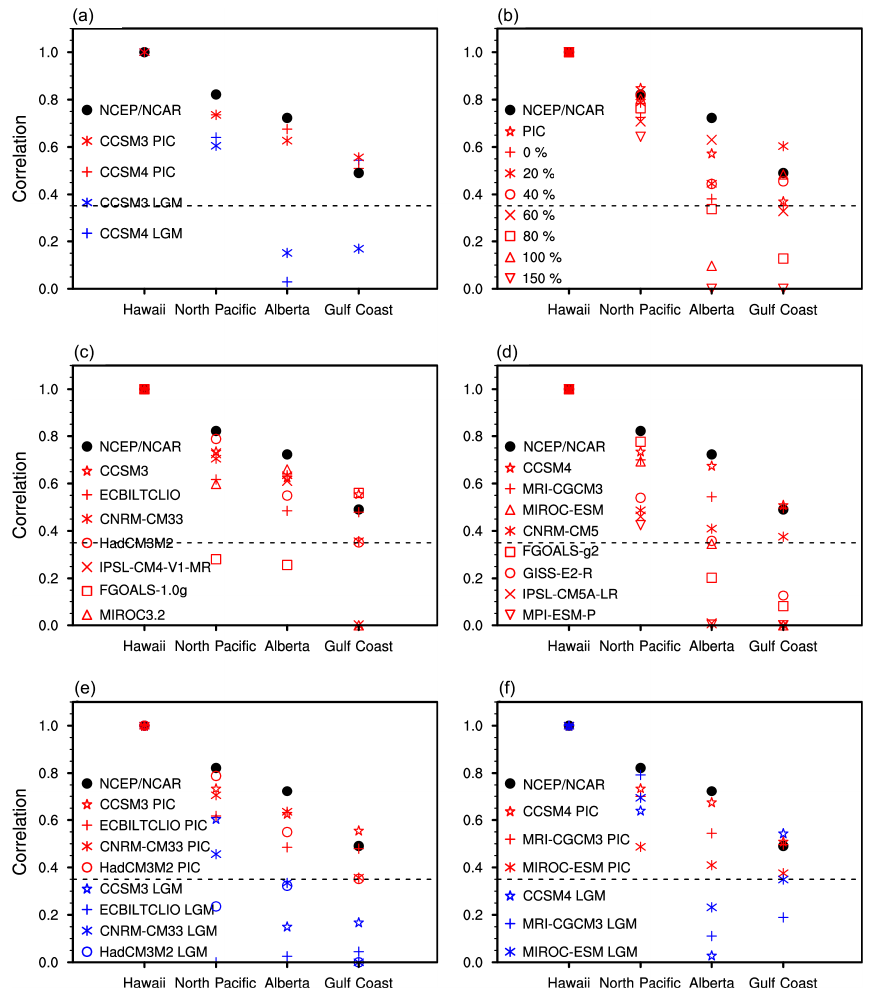
Figure 3. Correlation coefficients at the four PNA action centers in PIC and LGM simulations using PMIP2 and PMIP3 models, with the base point near Hawaii. The negative values over the North Pacific and the Gulf Coast are reversed to positive. The dashed lines correspond to 0.35, which represents the 95% confidence level. (a) CCSM3 and CCSM4, (b) sensitivity simulations, (c) PIC simulations using PMIP2 models, (d) PIC simulations in PMIP3 models, (e) LGM and PIC simulations using well-performing PMIP2 models, and (f) LGM and PIC simulations using well-performing PMIP3 models.